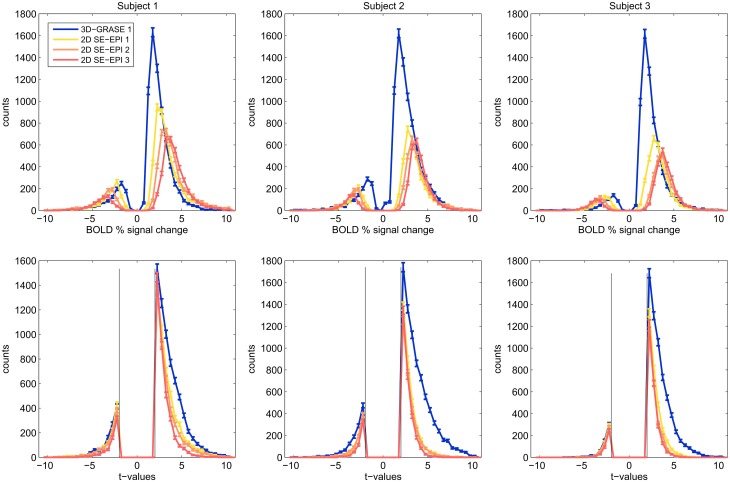
Histograms of significant voxels. Counts of BOLD signal changes (top) and t-values are shown for voxels, which responded significantly to the stimulation (t > 2.0, p < 0.046).